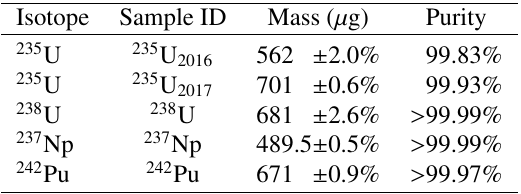
Table 1. Properties of the samples used during the